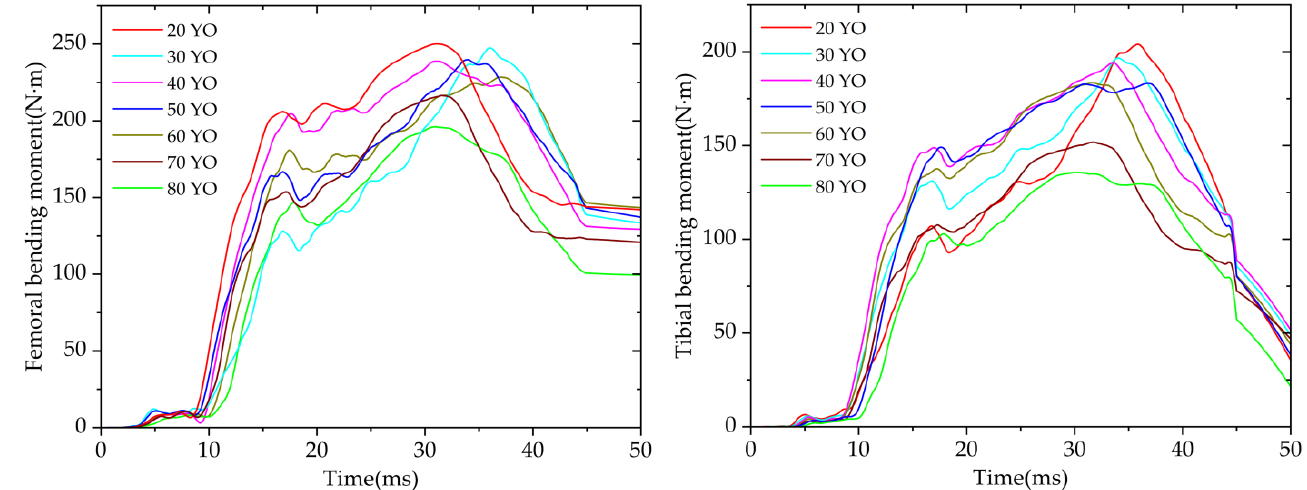
Figure 6. Bending moment of femur and tibia of pedestrians of seven ages at 40 km/h.